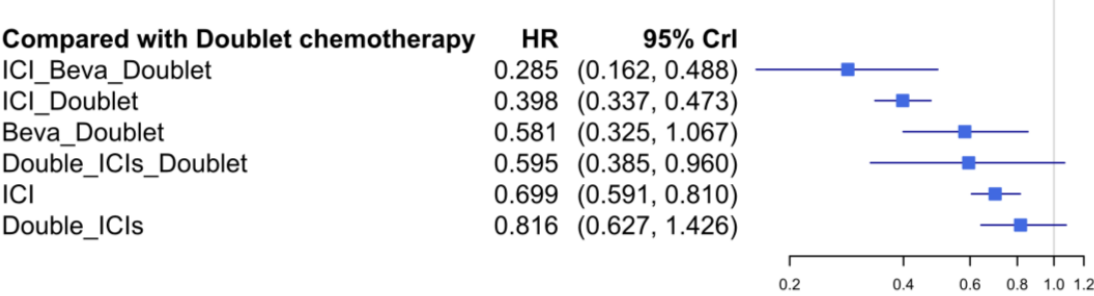
Figure 3. Network forest plot of treatment regimens compared with doublet chemotherapy for